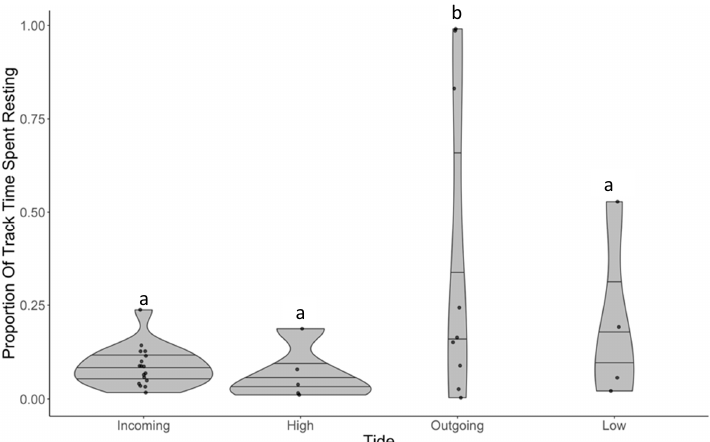
Figure 11. The proportion of time spent resting according to tide. Dots represent individual tracks. The lines represent the quantiles. The letters represent the Tukey test results indicating differences between groups.